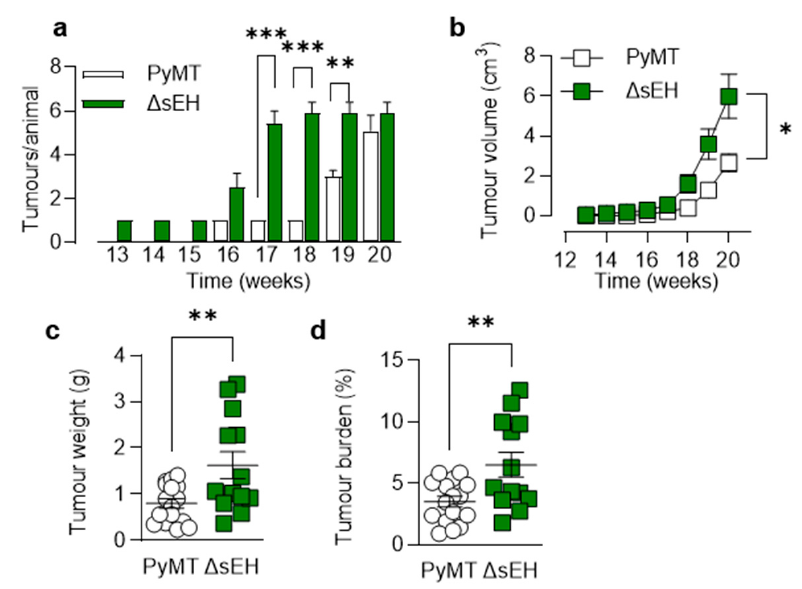
Figure 1. Consequences of sEH deletion on primary tumor growth. ( a ) Time-dependent increase in tumor number per animal from weeks 13 to 20; n = 8–13 animals per group. ( b ) Tumor volume per animal/week from weeks 13 to 20; n = 8–13 animals per group. ( c ) Total tumor weight at week 20; n = 13–19 animals per group. ( d ) Tumor burden (total tumor weight normalized to body weight) at week 20; n = 13–19 animals per group. * p < 0.05, ** p < 0.01, *** p < 0.001 (( a , b ) ANOVA for repeated measures and Newman–Keuls test, ( c , d ) Student’s t test).